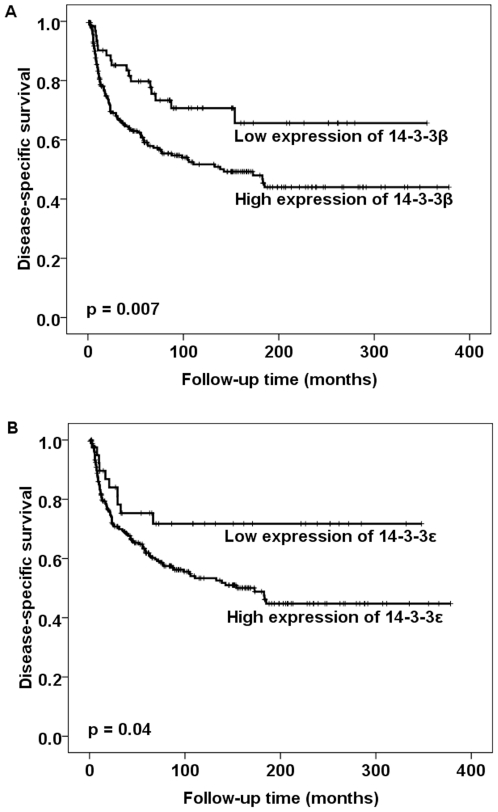
Survival curves using the Kaplan-Meier method.The Kaplan-Meier curve of disease-specific survival in relation to the cytoplasmic expression of 14-3-3β and ε. The p-value for 14-3-3β differs slightly from that in Table 1 based on the use of the log-rank test in Figure 2 as opposed to the use of the Cox-regression analysis in Table 1.